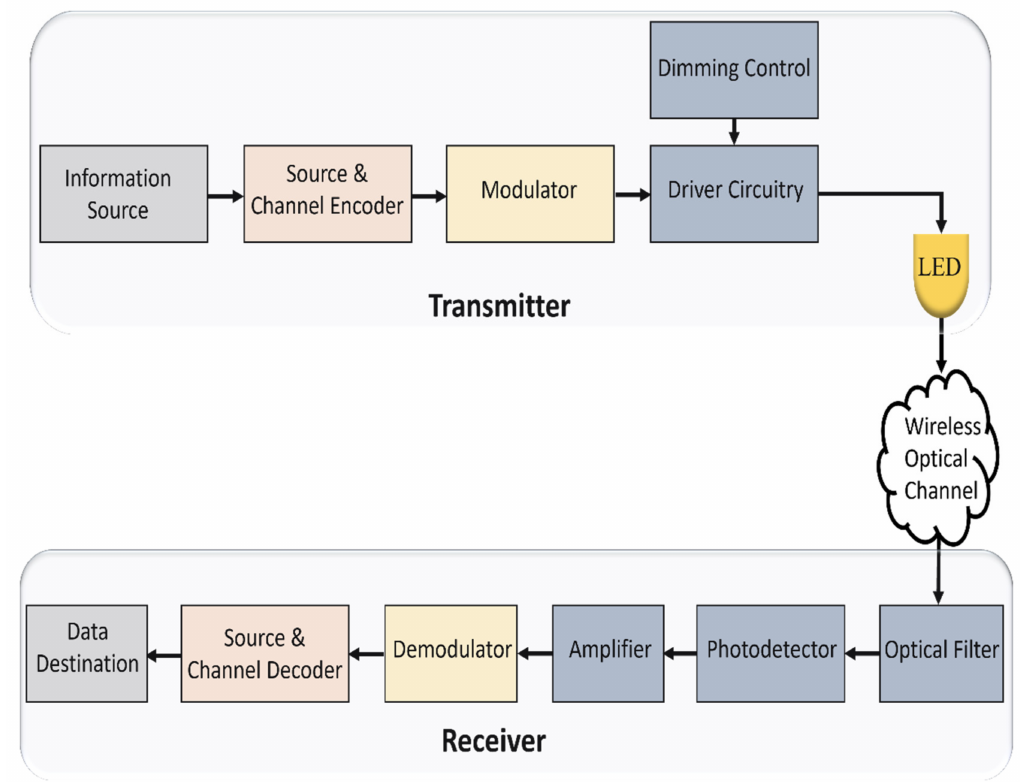
Figure 4. VLC system